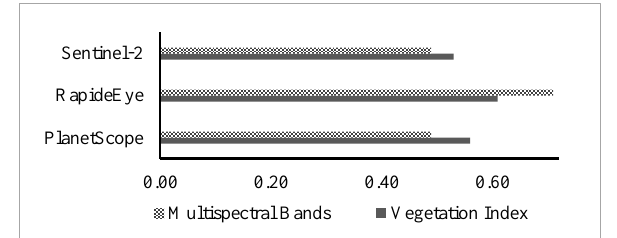
Figure 2. Highest obtained linear correlation (r 2 ) of observed aboveground biomass and satellite data 3.2 MARS Aboveground Biomass Models Vegetation indices, multispectral bands and an additional set of Sentinel-2 bands consisting of Red-edge 2-4 and two SWIR